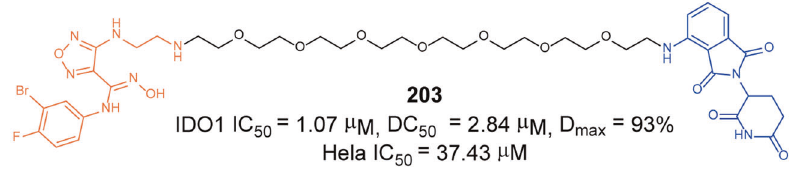
Fig. 58 The representative PROTAC targeting IDO1